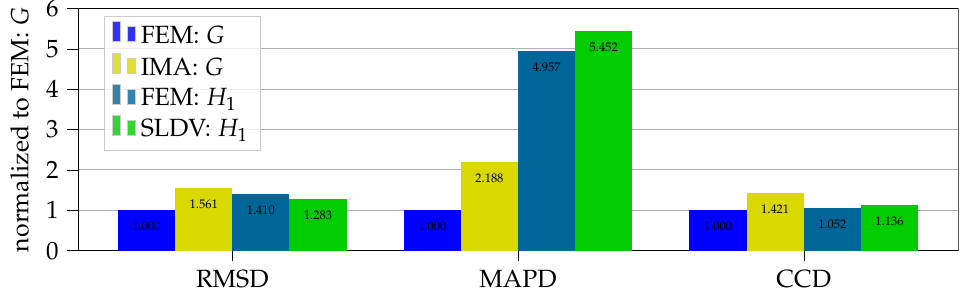
Figure 5. Comparison of damage metrices RMSD, MAPD and CCD for different spectrum elements (pristine vs. cracked for a in = 2mm, β in =